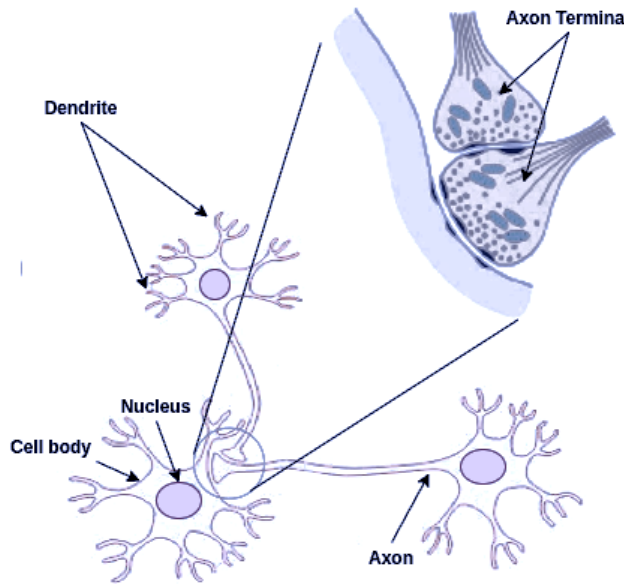
Figure 2. Biological neuron showing the axoaxonic